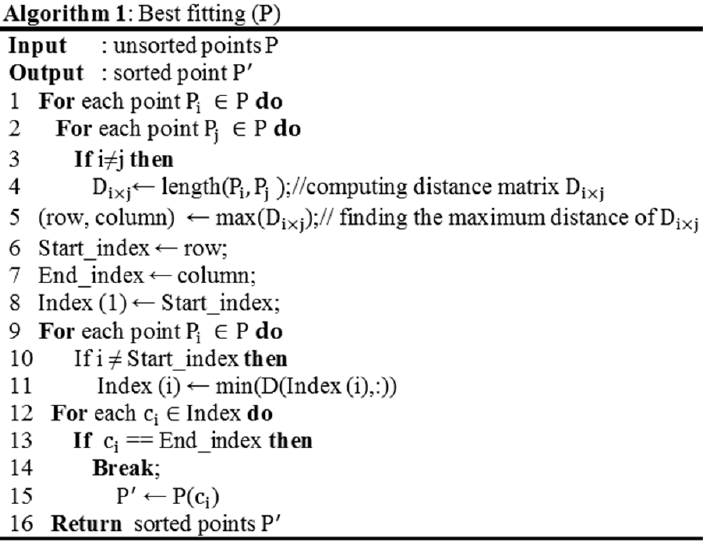
Figure 5. Pseudo-code representing Algorithm 1 .